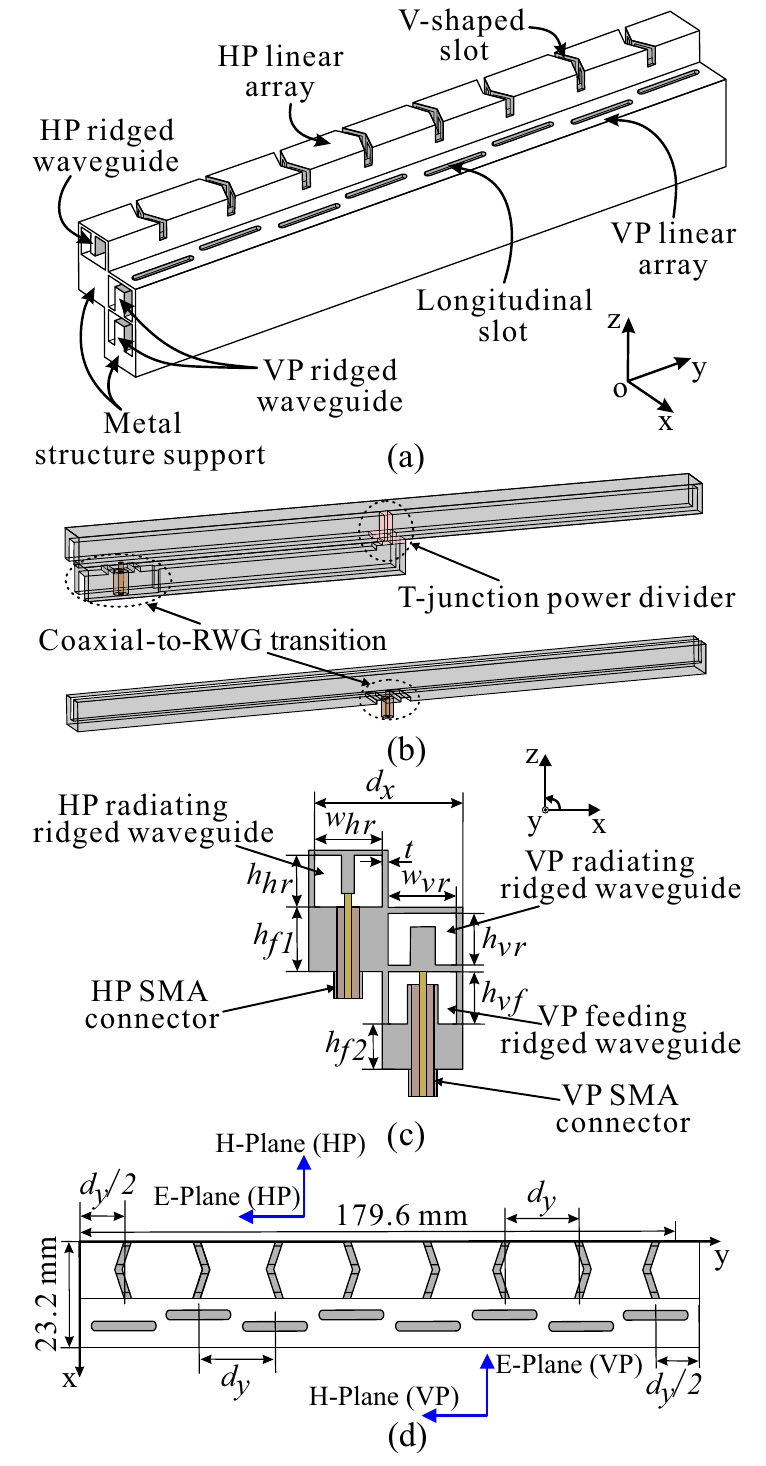
Figure 1. Geometry configuration of the proposed dual-polarization array. ( a ) 3-D view of complete structure. ( b ) View of the inside structure. ( c ) Cross section of the structure. ( d ) Top view of the radiating